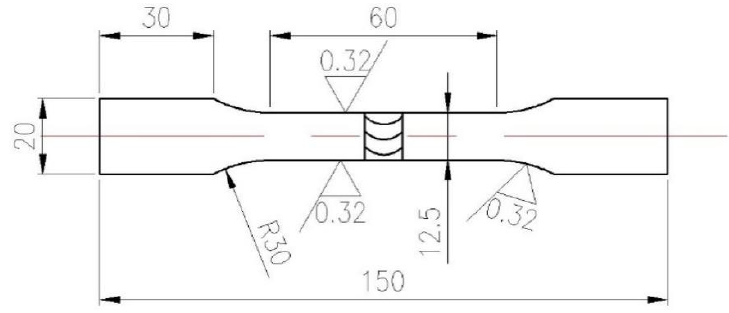
Figure 4. Dimensions of tensile specimen